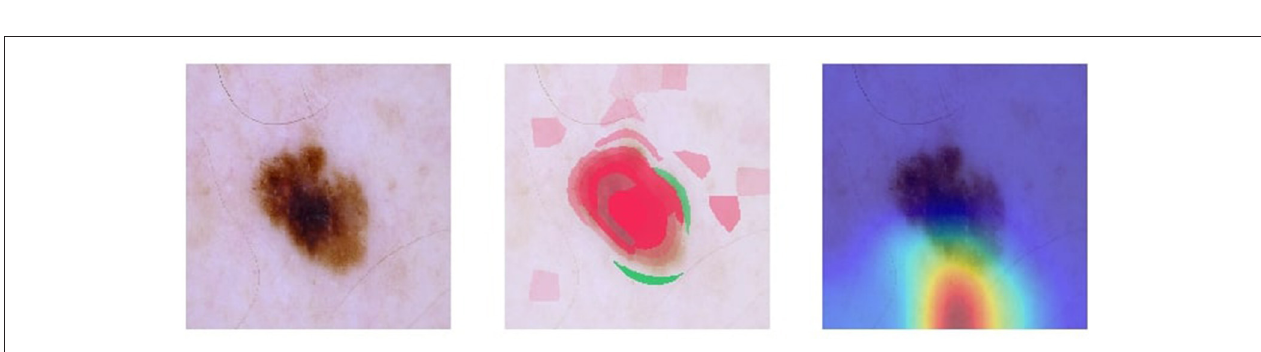
FIGURE 1 | Visual explanation images where AI algorithm correctly classified the skin lesion as melanoma (A) original image (B) SHAP visual explanation where green indicates the most important area of contribution to the AI result and red indicates the least important area; and (C) Grad-CAM visual explanation image where red is the most important area of contribution to AI result and blue is the least important part of the image to AI result. Image courtesy of Sally Shrapnel.